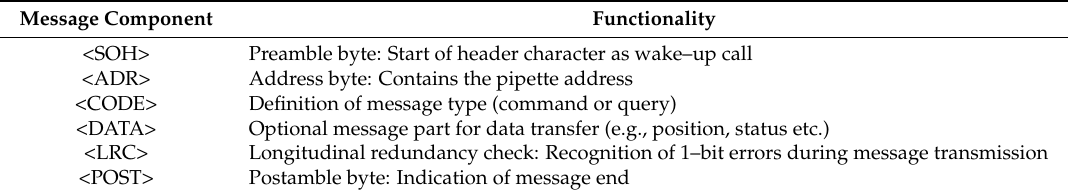
Table 1. Communication messages: Components and functionalities.